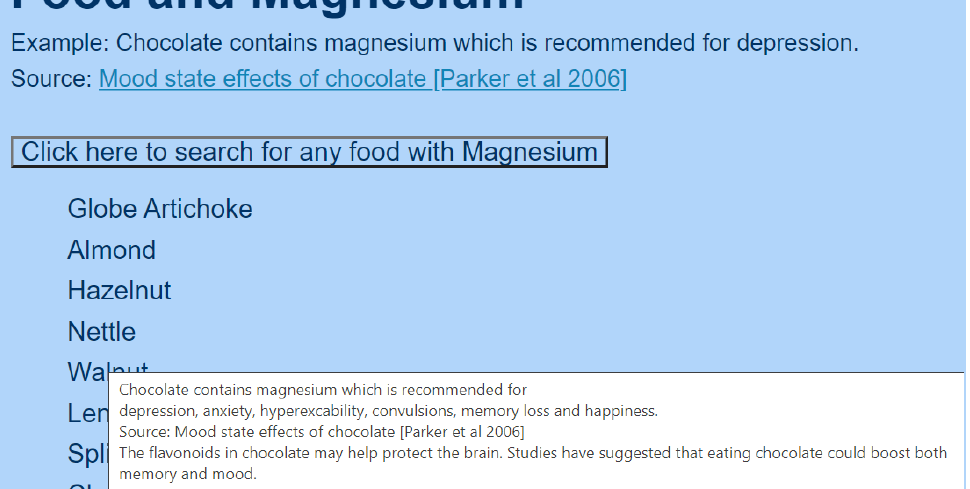
Figure A10. Food that contains magnesium which is recommended for depression, anxiety, etc.